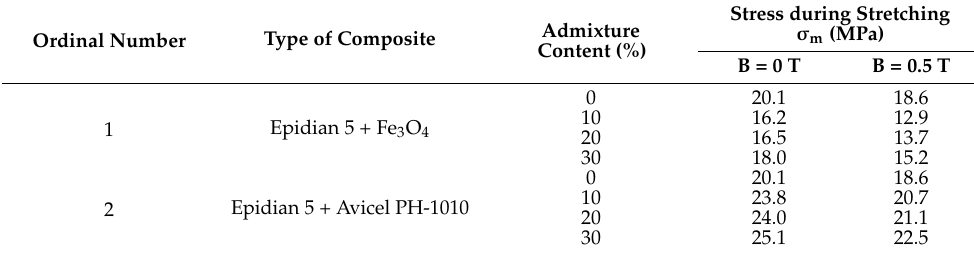
Table 12. Comparison of the mechanical tensile strength of composites.